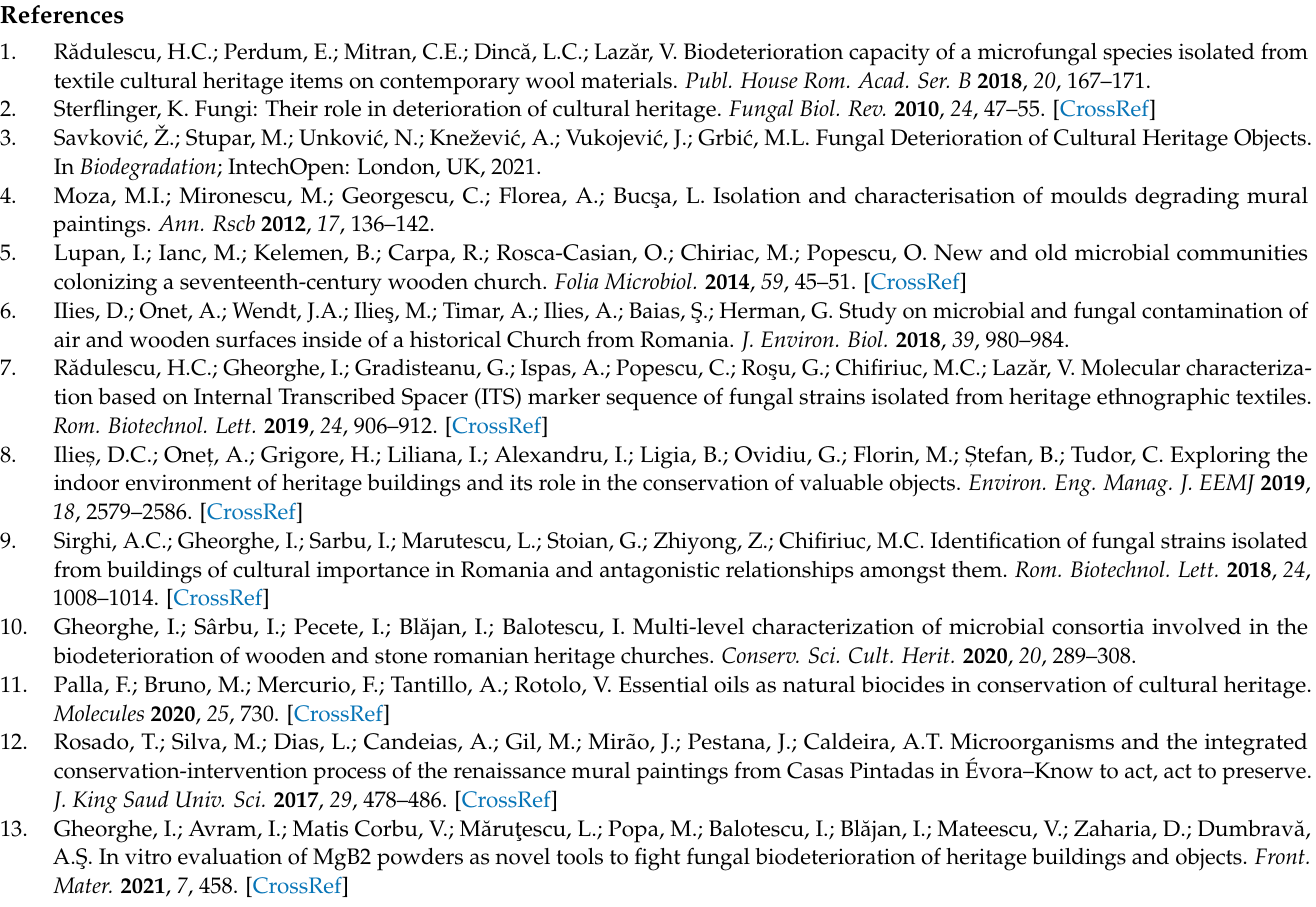
expressed by arbitrary units of growth inhibition zones